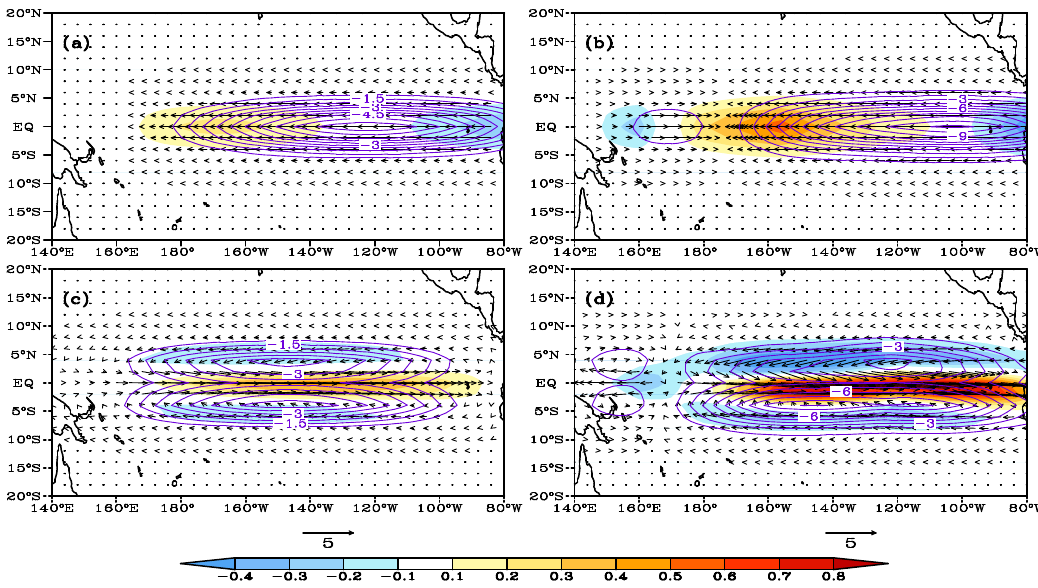
Figure 10. The responses of the Kelvin wave ( a is CP-El Niño, and b is EP-El Niño) and the Rossby wave ( c is CP-El Niño, and d is EP-El Niño) to the heat sources of two types of El Niño. The continents are shown just for geographical reference.